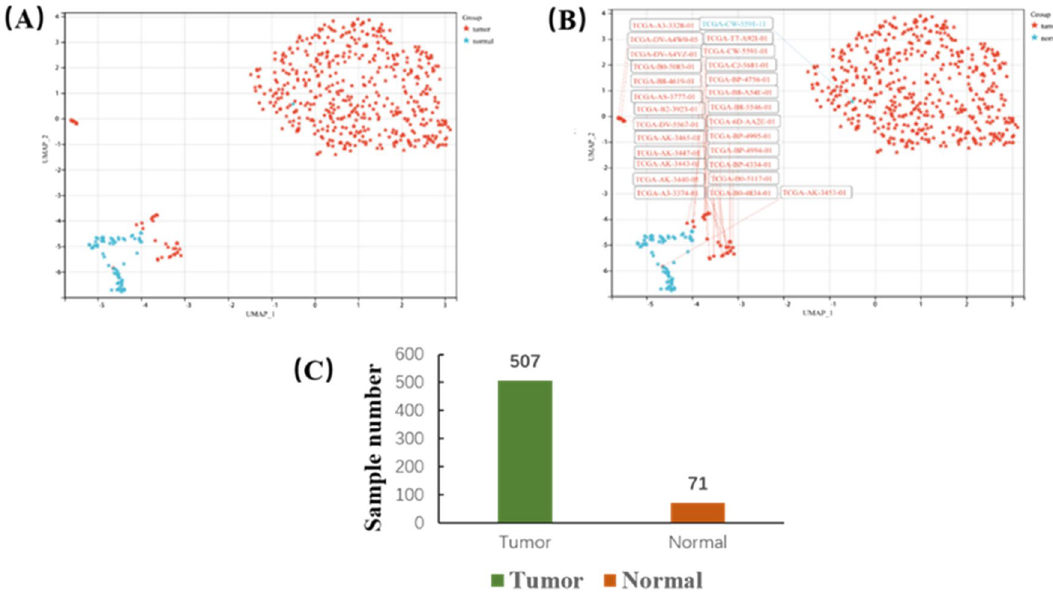
Figure 2. Identification of 71 normal and 507 KIRC samples by PCA. ( A ) Principal component analysis. Red dots represent tumor samples; blue dots represent normal samples. ( B ) Exclusion of 26 tumors and 1 normal sample after PCA. ( C ) Principal component analysis result.